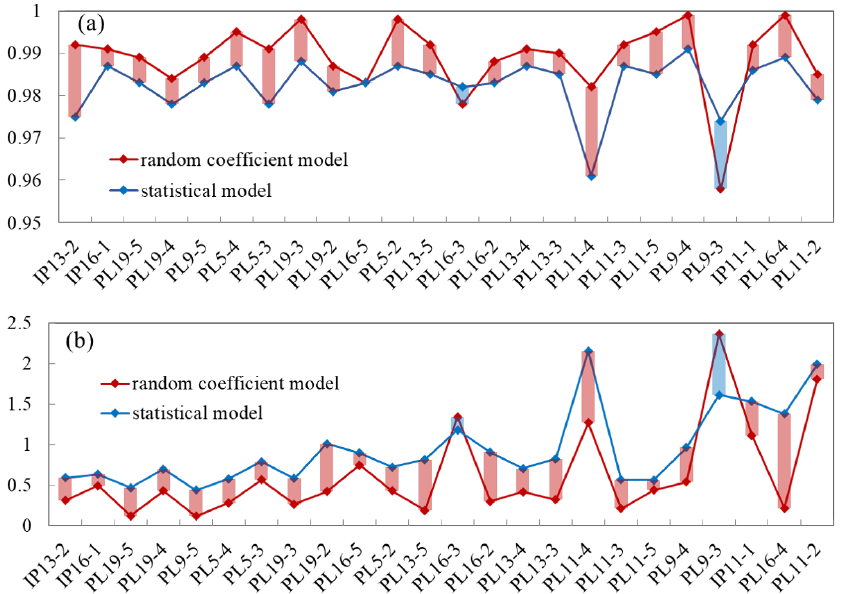
Figure 12. Comparison of ( a ) R and ( b ) s for a random coefficient model and statistical